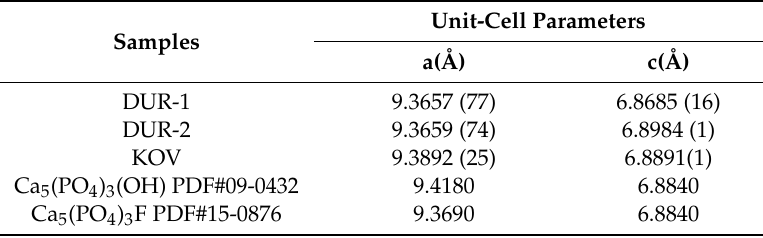
Table 1. Unit-cell parameters of Durango and Kovdor